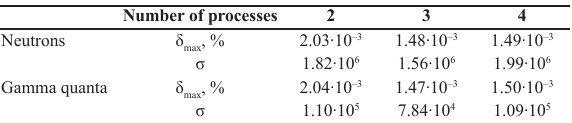
Table 5. Comparison based on calculation results for full parti- cle fluxes with the Cherenkov cluster Number of processes